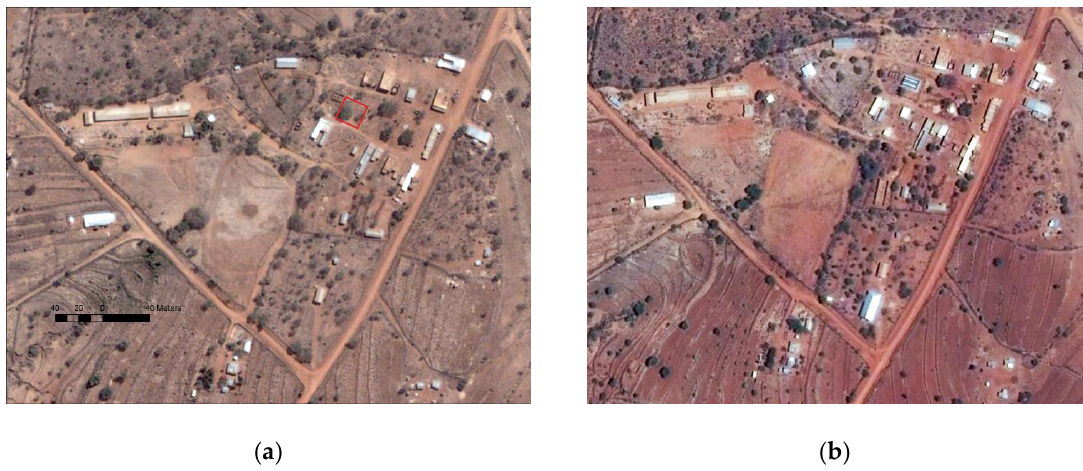
Figure 4. ( a ) Kitonyoni trading centre in 2012, prior to energy access intervention. Red square is the (future) location of the solar power plant; ( b ) Kitonyoni trading centre in October 2013, 1 year after the installation of the solar mini-grid.